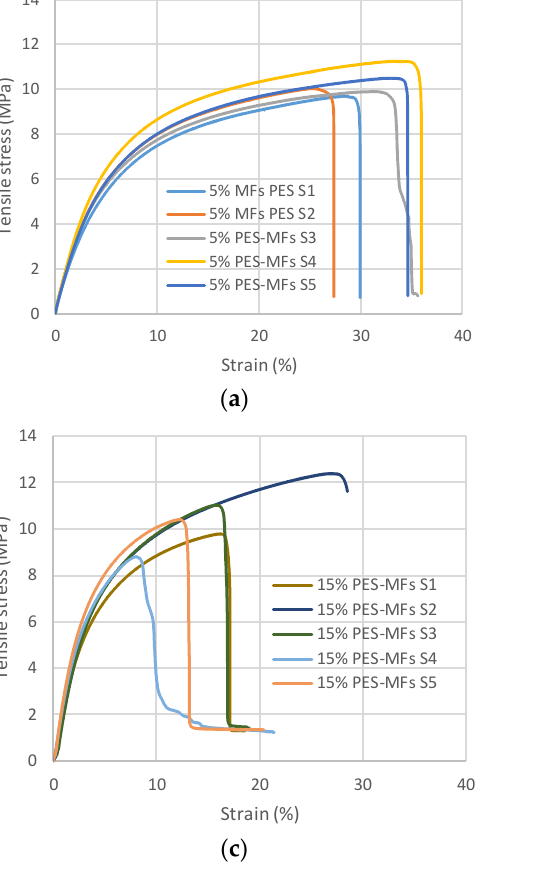
Figure 2. Strain (%) versus tensile stress (MPa) of composites with different compositions of polyester microfibers (PES-MFs) in the low-density polyethylene matrix (LDPE): ( a ) 5% PES-MFs; ( b ) 10% PES-MFs; ( c ) 15% PES-MFs; ( d ) pure LDPE.